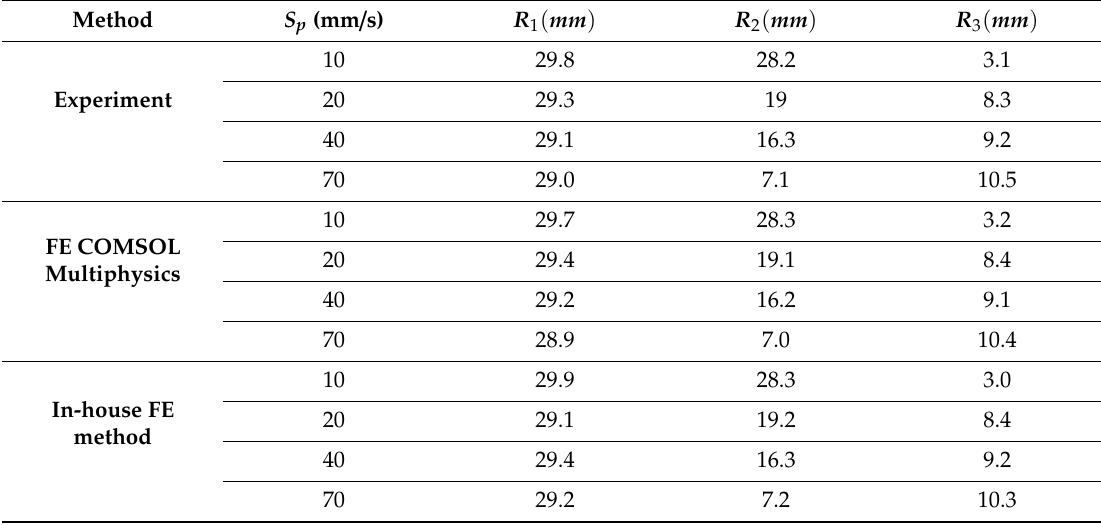
Figure 8. Finite element (FE) COMSOL Multiphysics simulation of the samples 4D-printed with different speeds of ( a ) 10, ( b ) 20, ( c ) 40, and ( d ) 70 mm/s after the heating – cooling process. Table 4. The geometric parameters of the beam-like 4D structures after the heating – cooling process.